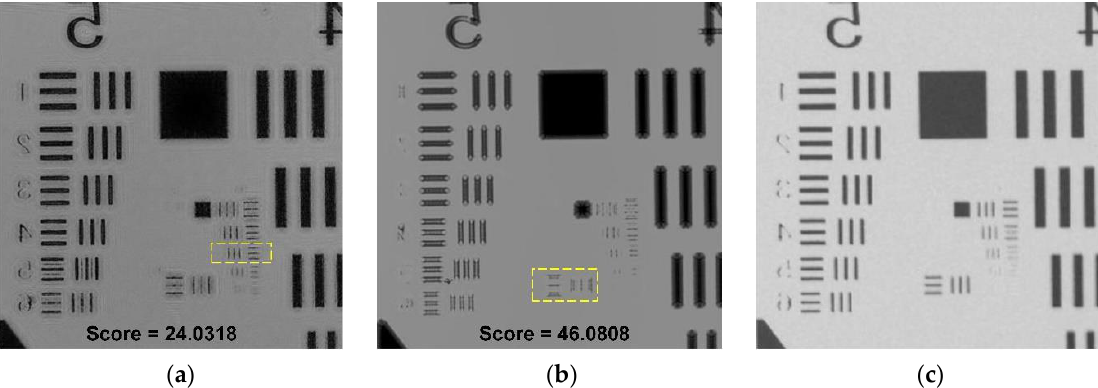
Figure 3. Comparison of images taken by different systems. ( a ) Iteratively recovered image, ( b ) shadow image, ( c ) microscope image. Table 1. The results of reference image quality evaluation.